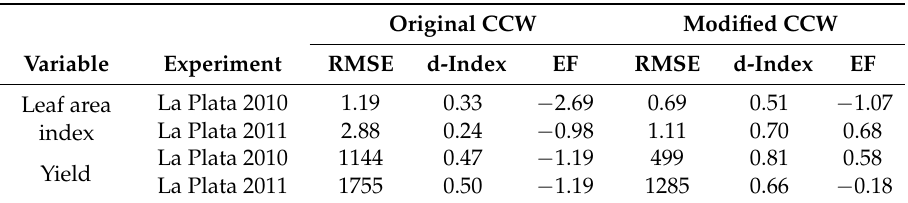
Figure 3. Simulated vs. measured yield (kg DM ha − 1 ) for calibration and validation for all ten cultivars on the location La Plata 2010 ( a ) and La Plata 2011 ( b ). Table 3. Statistical evaluation of the simulation of leaf area index and grain yield of the original CCW model and the developed CCW model extension for diseases using root mean square error (RMSE), Willmott’s d statistic (d-Index) and modelling efficiency (EF).